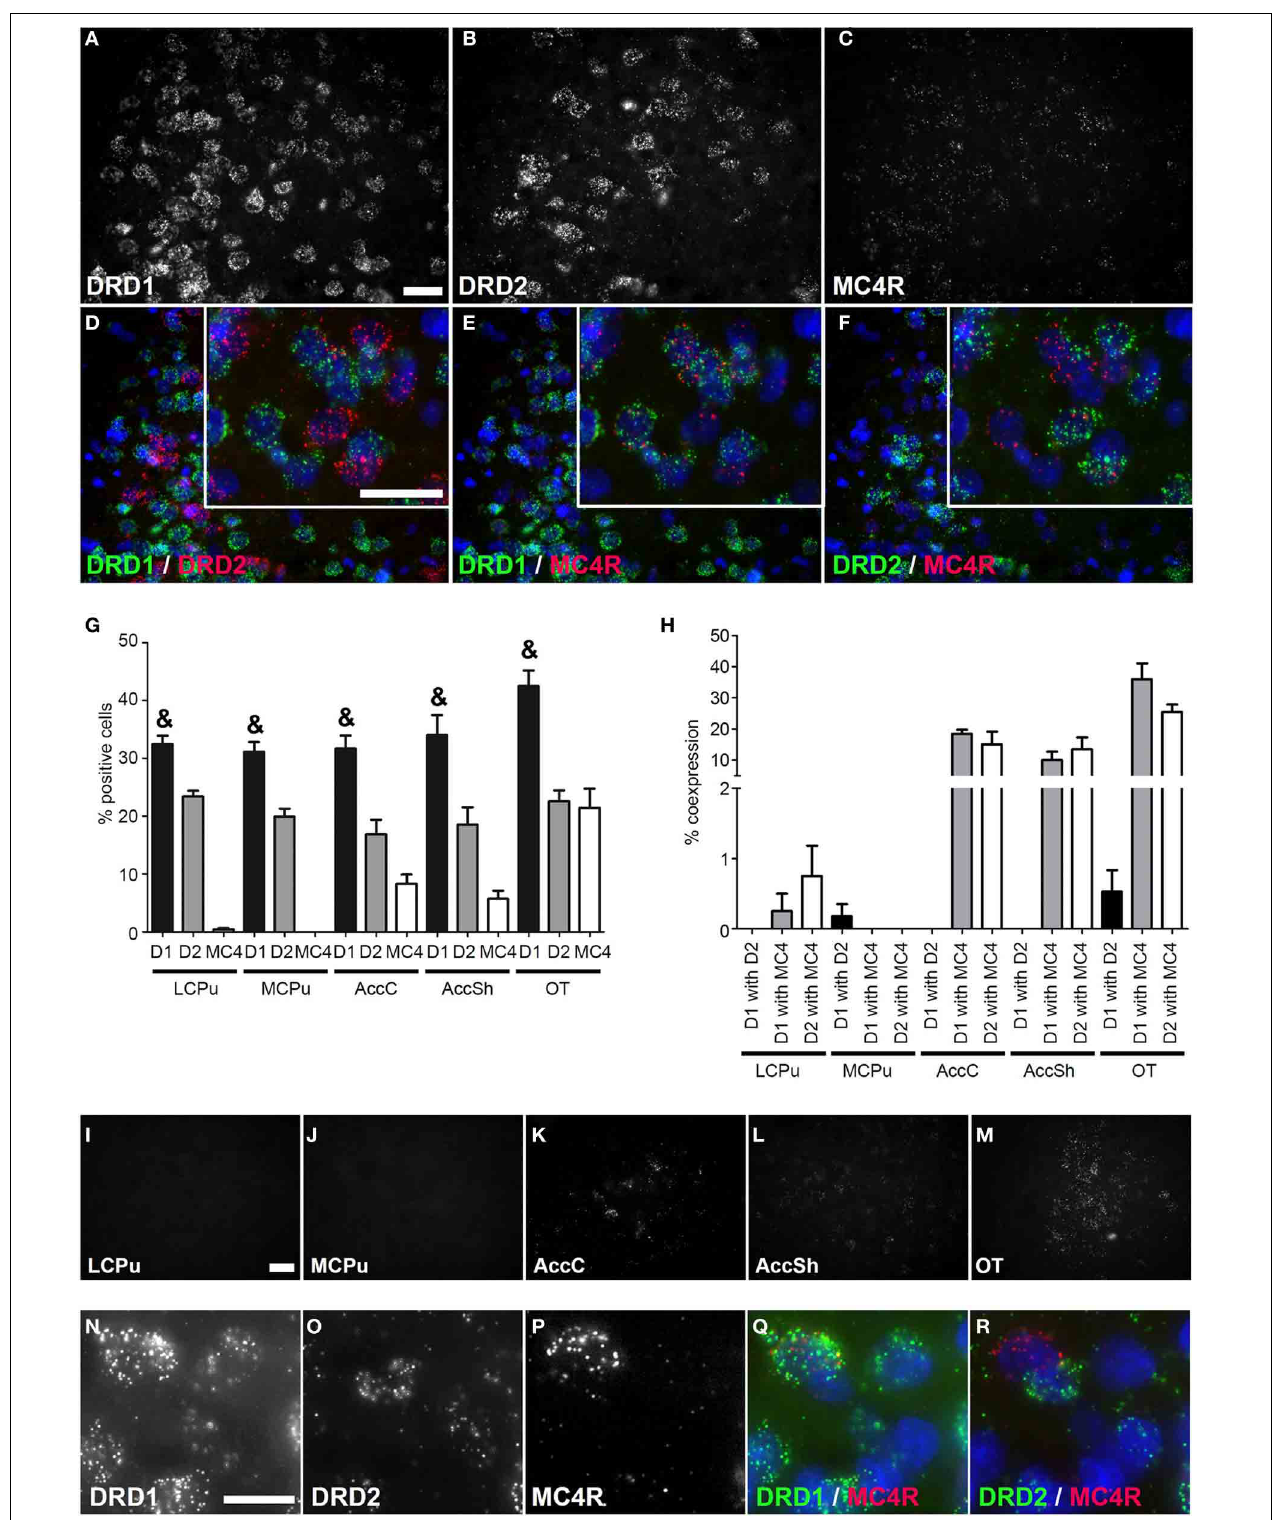
FIGURE 3 | Coexpression of the melanocortin 4 receptor with both DRD1 and DRD2 . (A–F) Example of staining in the OT. Nuclei were stained using DAPI (blue). Clear expression for the DRD1 (A) , DRD2 (B) , and modest expression for melanocortin 4 receptor ( MC4R ) (C) . Enlargements of cells are depicted expressing both DRD1 and MC4R ,